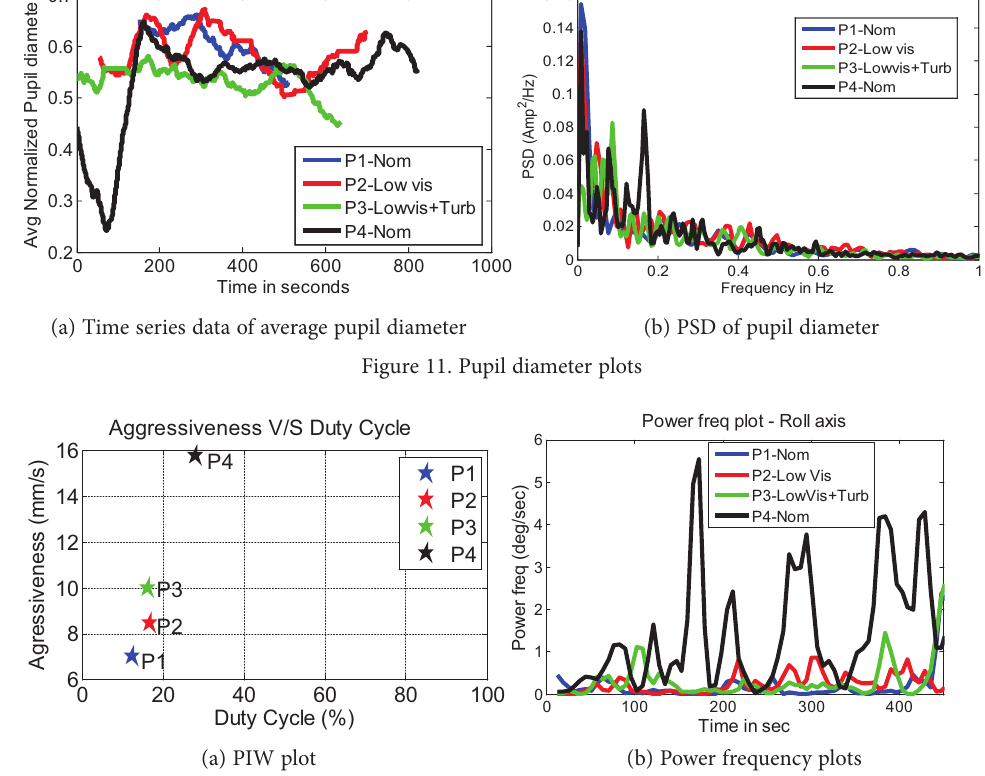
Figure 12. Pilot’s control strategy on pitch and roll control columns